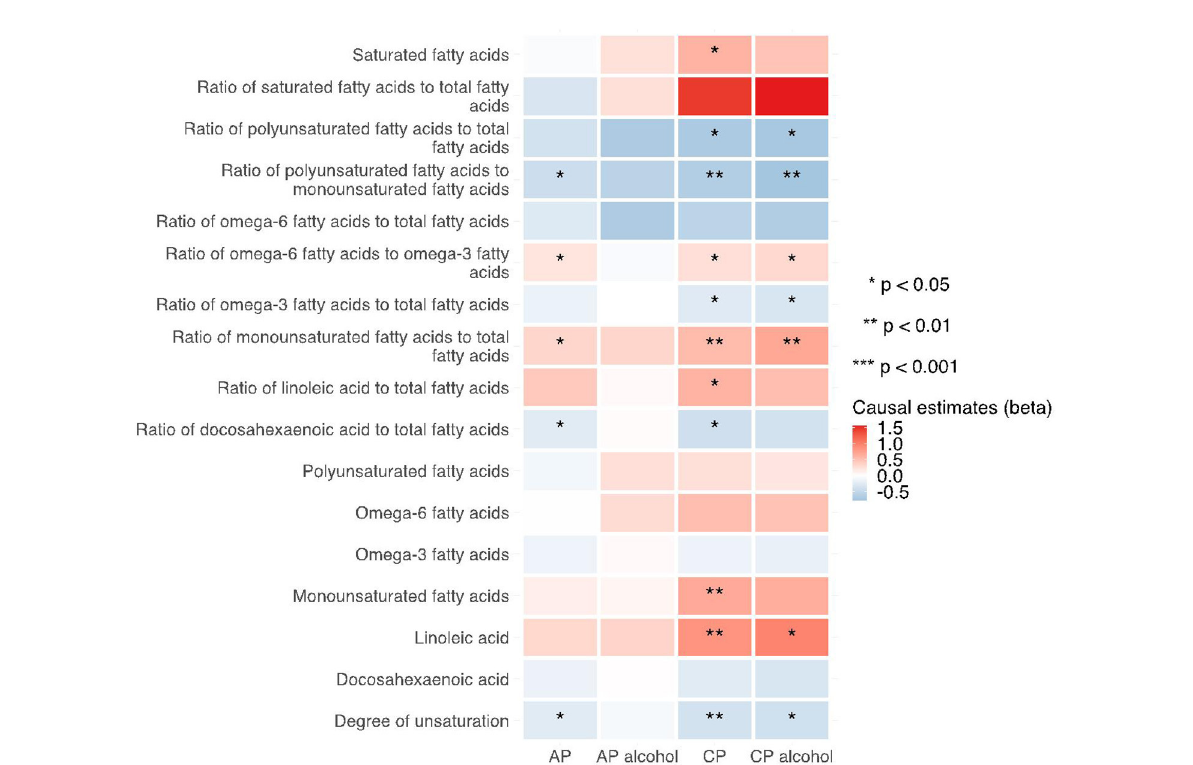
FIGURE7 Heatmap showing the MR-egger causal estimates of traits related with fatty acid (un)saturation in met-d on pancreatitis using two-sample MR. AP, acute pancreatitis; CP, chronic pancreatitis; IVW, inverse-variance